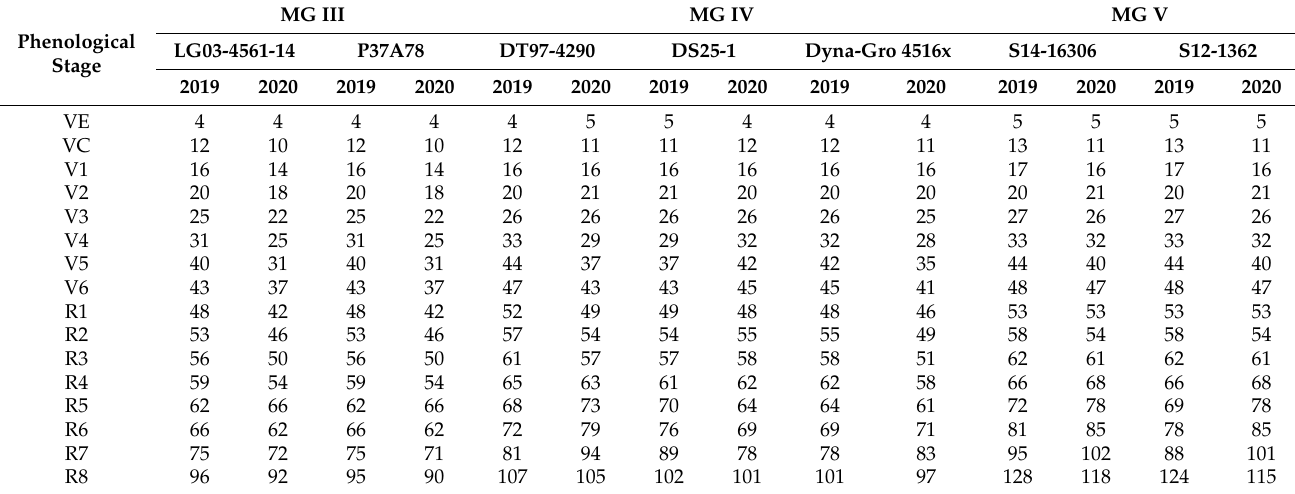
Figure 1. Measured ( a ) air temperature, ( b ) precipitation, ( c ) daily and cumulative growing degree days (GDD), and ( d ) solar radiation for 2019 and 2020 soybean growing seasons at Stoneville, MS. AGDD = Aggregate GDD over a crop season. Table 3. Phenology of the maturity group III, IV, and V improved soybean cultivars during 2019–2020 crop seasons at Stoneville MS.